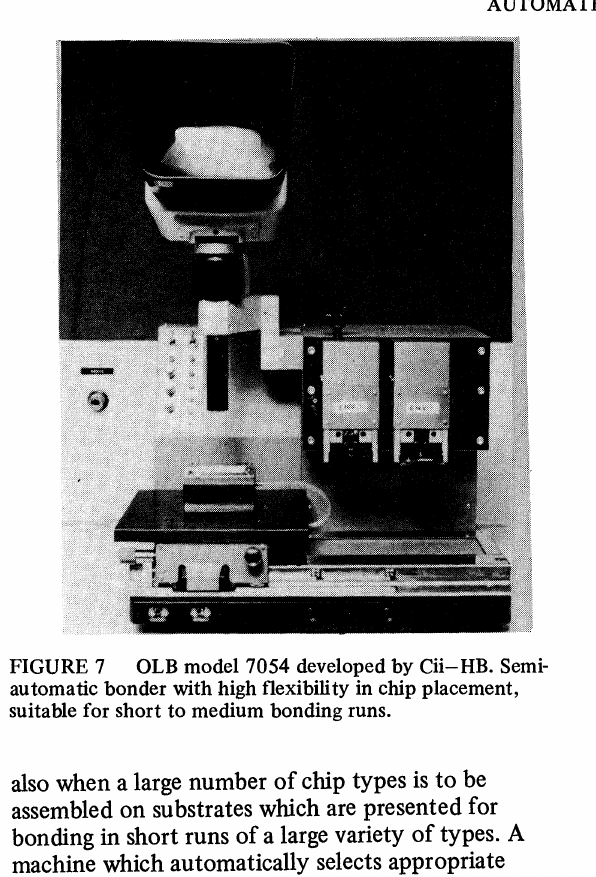
OLB model 7054 developed by Cii-HB. Semi- automatic bonder with high flexibility in chip placement, suitable for short to medium bonding